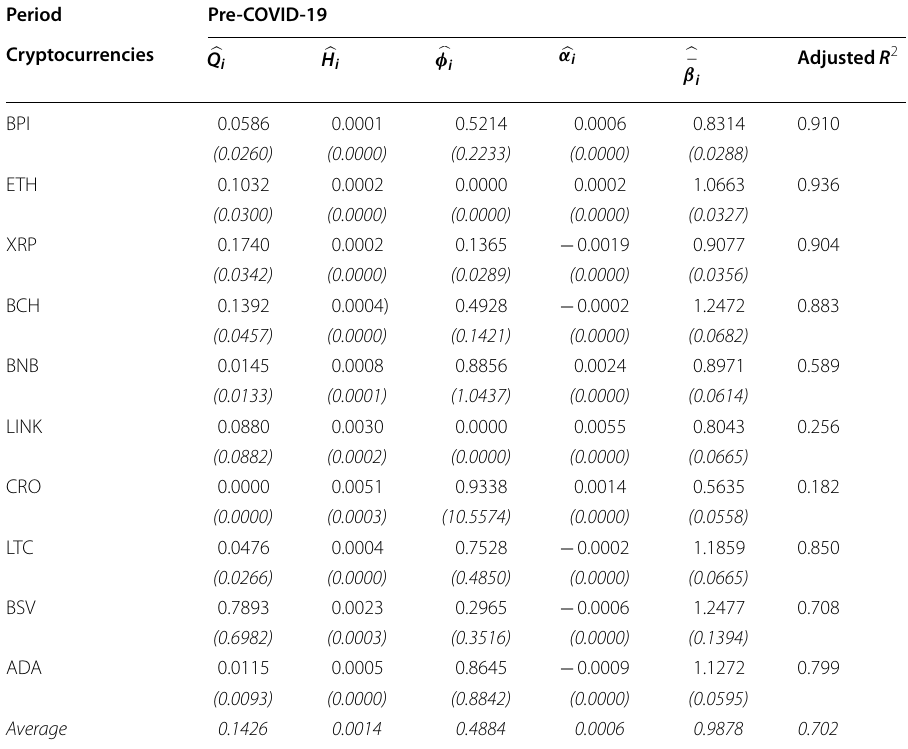
Table 8 Tv-LMM via KFMR parameter estimates (with standard errors ) of cryptocurrencies during the pre-COVID-19